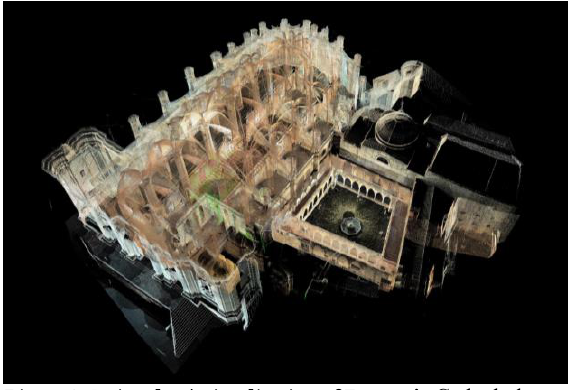
Figure 2. Point cloud visualization of Tortosa’s Cathedral. The software Cyclone was used to process the point cloud. It automatically registered the reference targets of each station and placed the point clouds in the same local coordinate system.